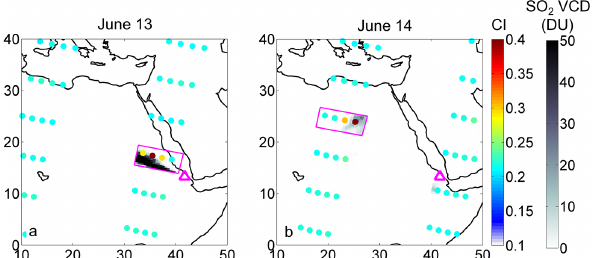
Figure 4. Maps of the SCIAMACHY Colour Index at a tangent height of 18 . 6km for the region around the Nabro volcano on 13 June (panel a ) and on 14 June 2011 (b) . SO 2 columns (in DU) from SCIAMACHY are shown in the background with a grey colour scale. The volcano is marked by a pink triangle; the pink boxes de- note the two SCIAMACHY states to which the limb extinction re- trieval was applied (Fig. 5).